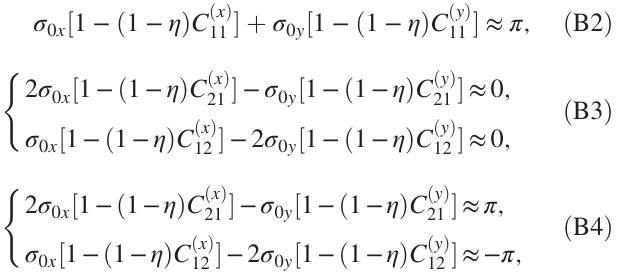
ð 2 ; 1 ; 0 Þ and (1,2,0) in Eq. (B5) with the minus sign. These lines have been reproduced in the PIC simulations in Fig. 13. On the other hand, the third-order difference resonance lines with ð k; l ; n Þ ¼ ð 2 ; 1 ; 1 Þ and ð 1 ; 2 ; − 1 Þ given in Eq. (B4) are invisible in experiment. According to the PIC data, the emittance growth rate along the resonance lines in Eq. (B4) is a few percent or less while the rate is about twice higher along another third-order lines in Eq. (B3). This may be why the weaker resonance lines with n ¼ (cid:2) 1 are undetectable with S-POD.